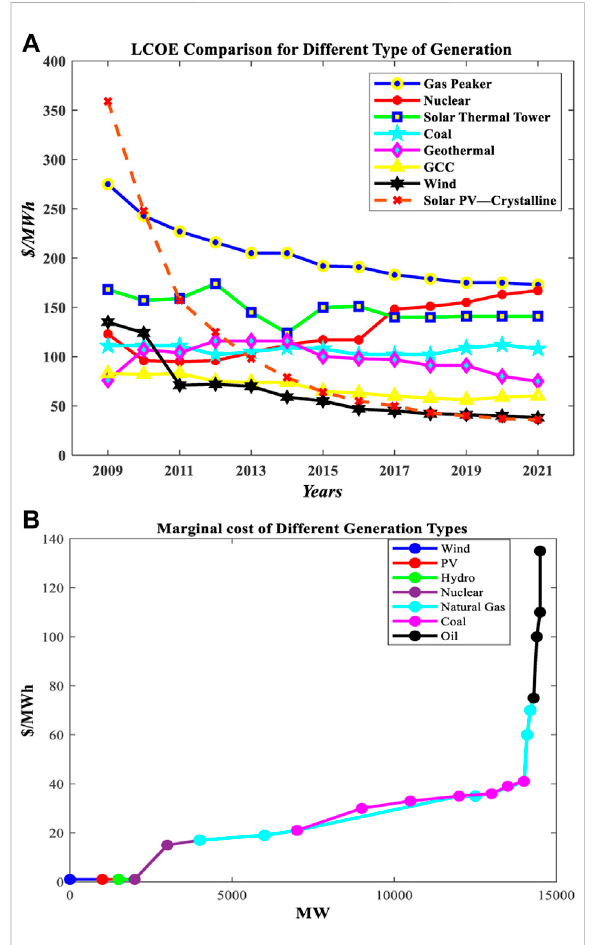
FIGURE 1 Comparison between different types of generation (A) LCOE comparison, (B) Marginal cost comparison (Hartman, 2016; Ray, 2021).